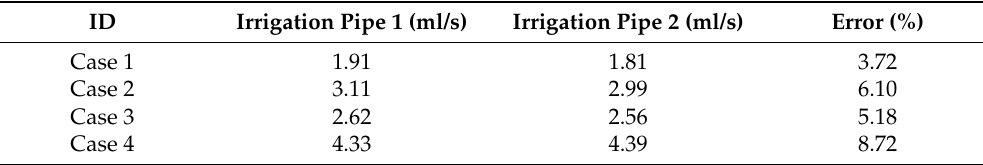
Table 7. Theoretical flow rate of each irrigation